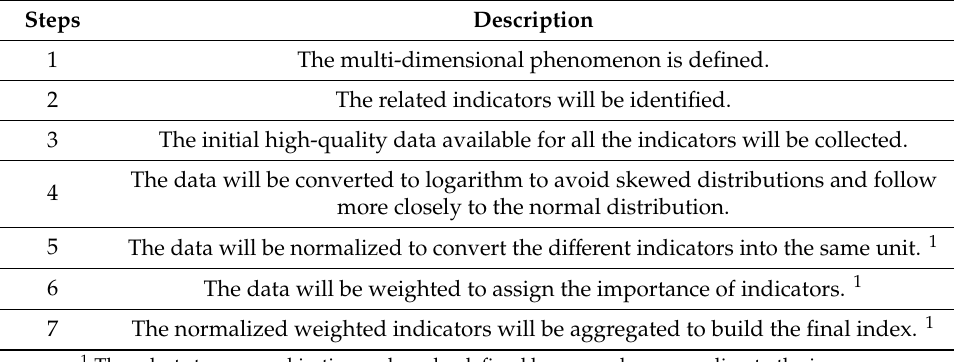
Table 1. Statistical steps in the construction of a composite indicator; Source: